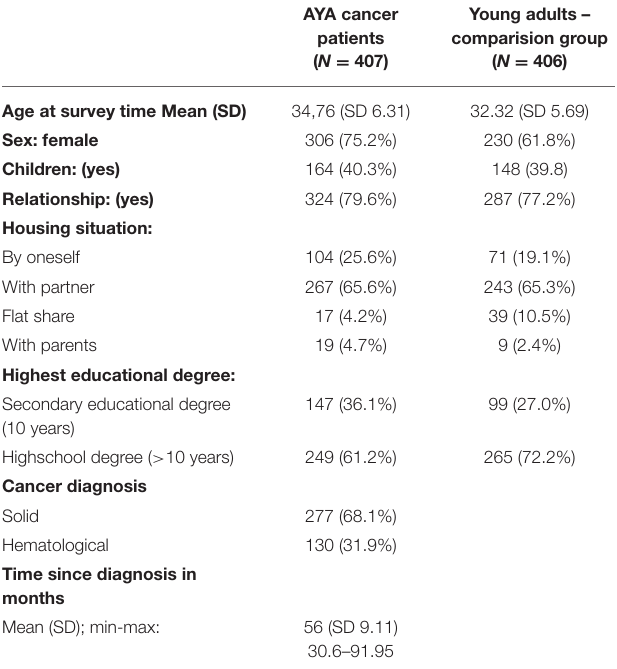
TABLE 2 | t4-Follow-up characteristics of the patient sample (AYA = 407) and the comparison group (CG = 406). AYA cancer